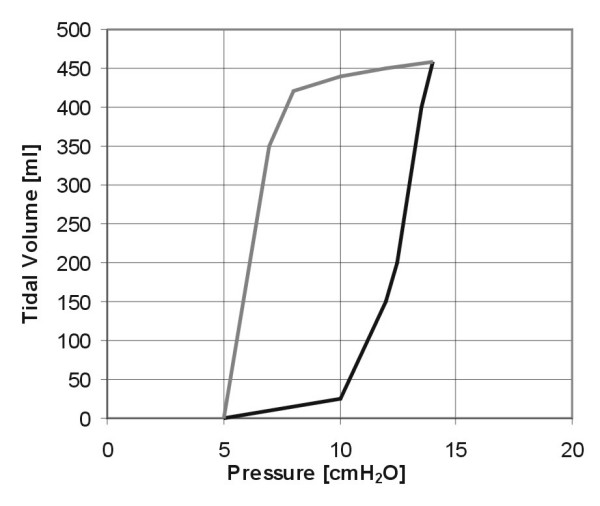
Normal lung. PV loops produced by model with PEEP at 5 cmH2O and Tidal volume of 450 ml. The plot shows a typical shape of PV curve produced by the model. Both inflation and the deflation limb follow the general trend of sigmoid curve.